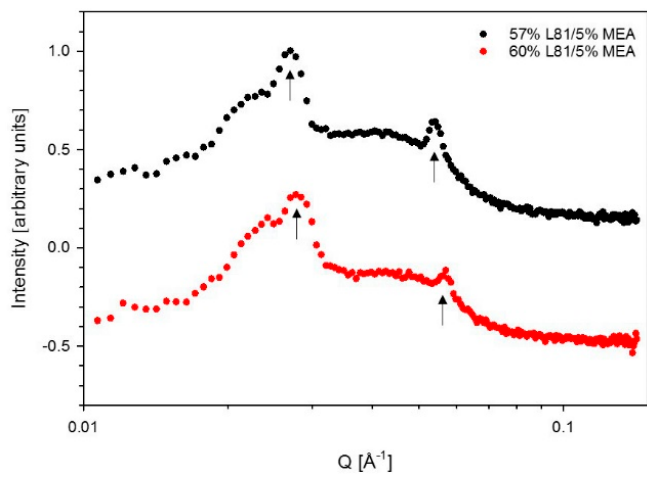
Figure 7. Phase diagram of Pluronic L81/water/MEA. Polymers 2018 , 10 , x FOR PEER REVIEW